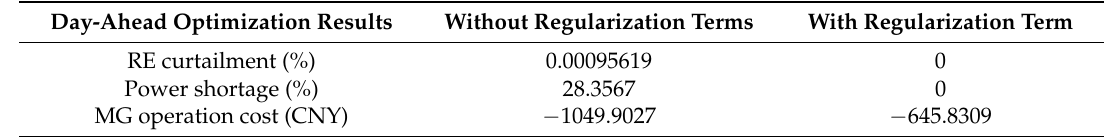
Table 7. Comparison test for the verification of effects of regularization terms in day-ahead optimization model.